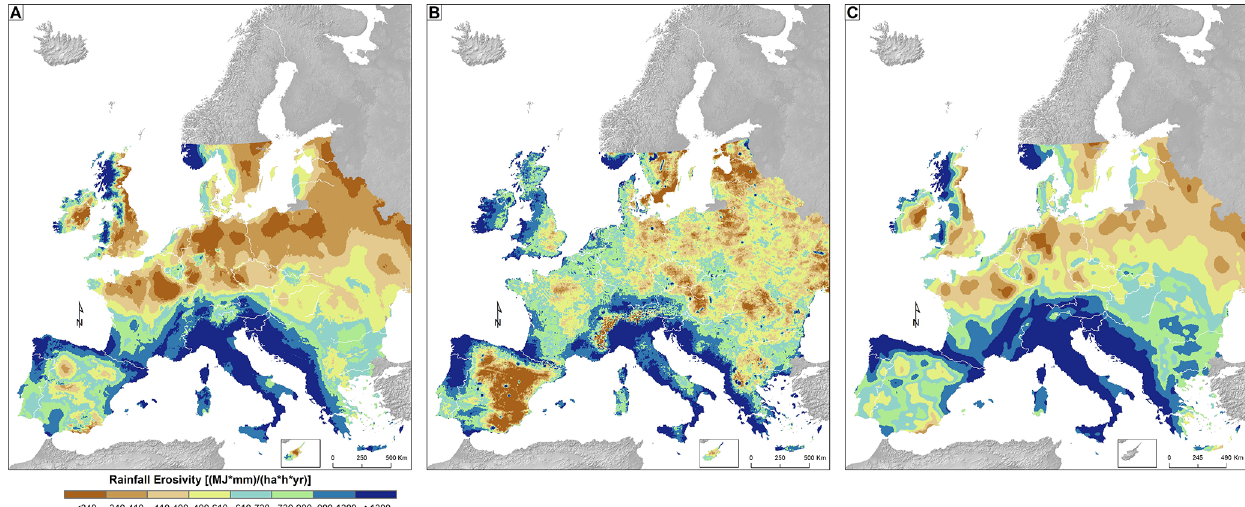
Figure 6. Comparison between the GloREDa rainfall erosivity map prepared by Panagos et al. (2017) (a) , the CMORPH-derived rainfall erosivity map (b) , and the ED-concept-derived map (c) for